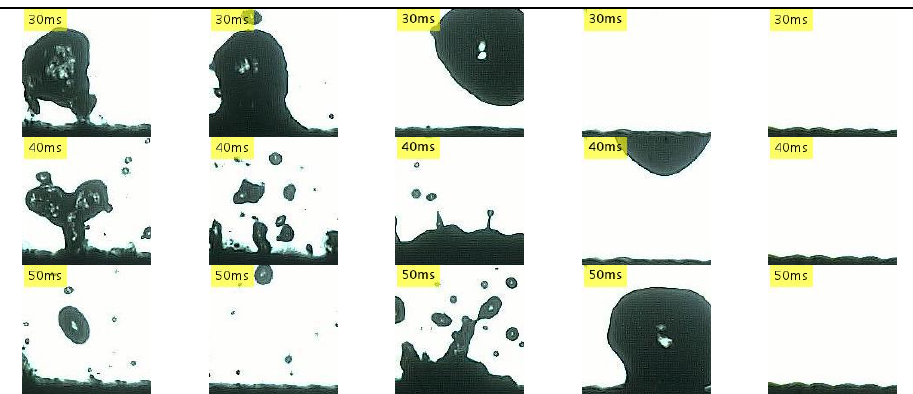
Figure 12. Sequential images of drop impact on nano-#60 mesh surface. Scale bar is 1 mm.